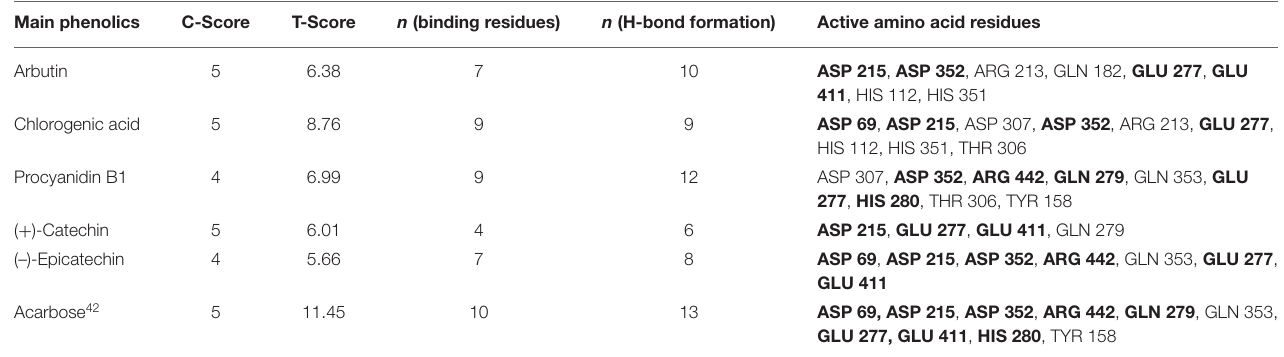
411 , HIS 112, HIS 351